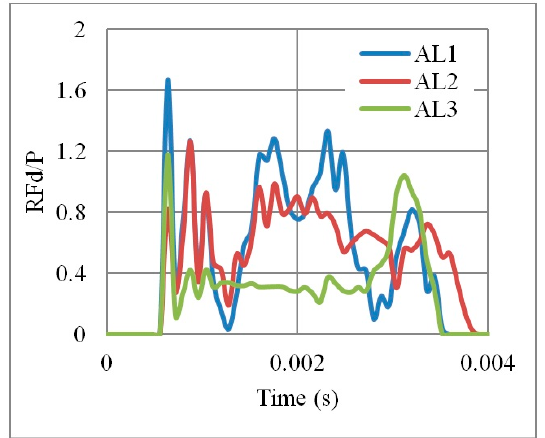
Figure 12. RFd/P time history, for 3 different Aluminium grades AL1, AL2 and AL3, of an auxetic core with L = 10 mm, t = 2mm, t/L = 0.2.